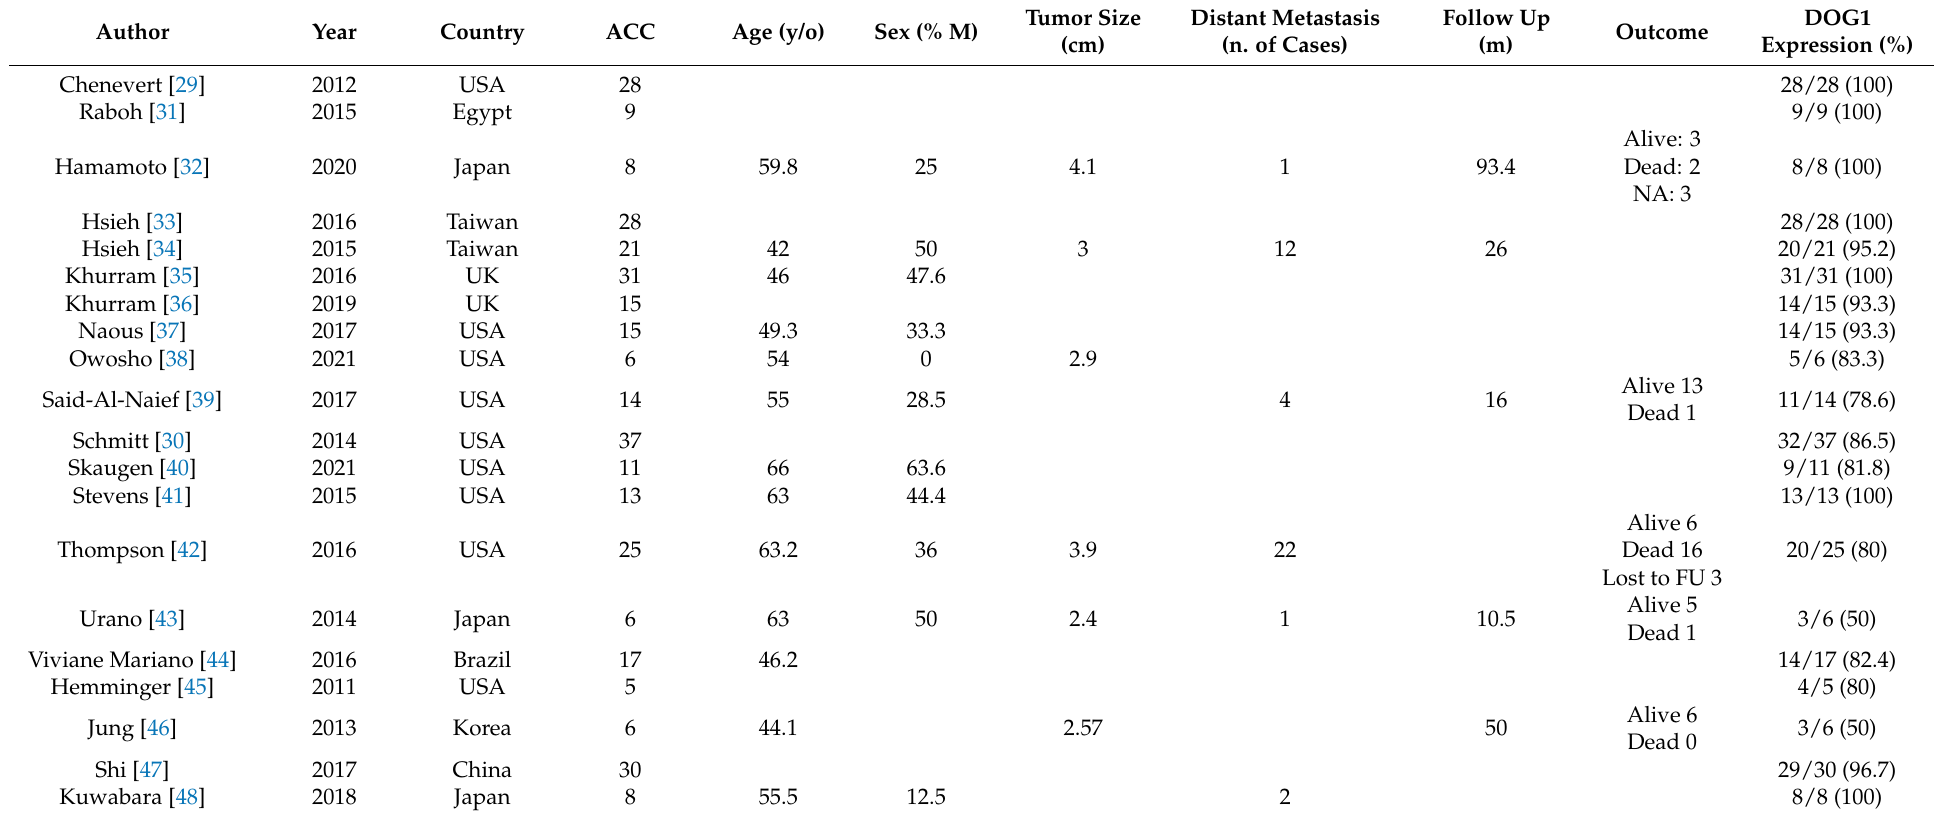
Table 2. Characteristics of included